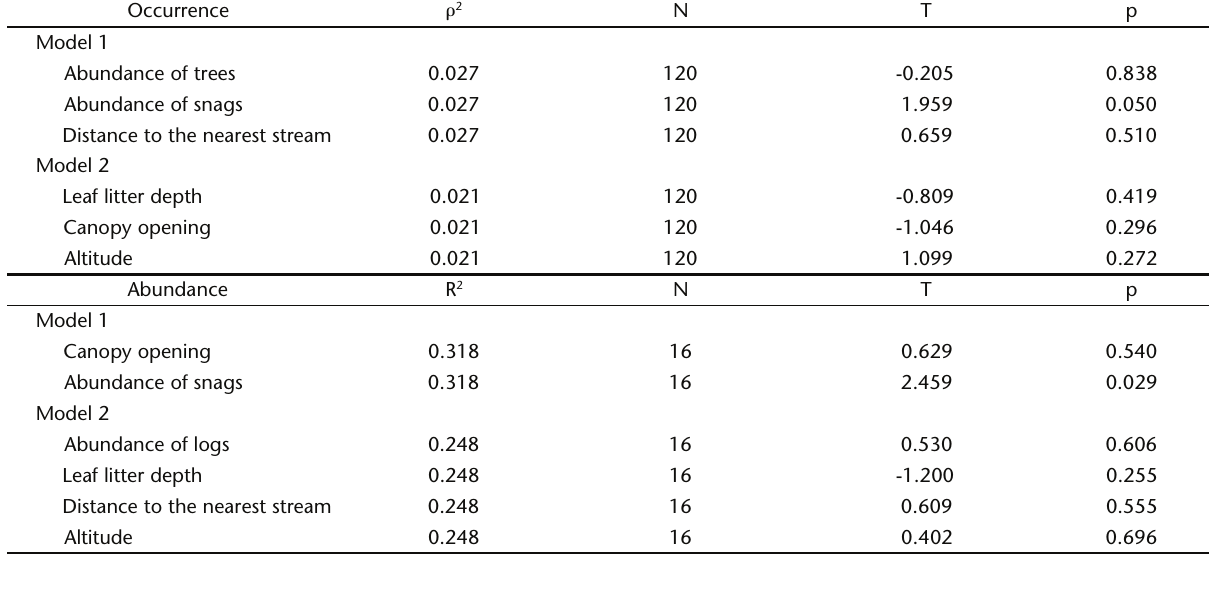
Table V. Results of the multiple logistic regression for frequency of use (occurrence) of different sites in the forest by L. cristata (categorical variable 0 = owl absent, 1 = owl present) and results of the multiple linear regression for owl's abundance in relation to the forest structure components and features of